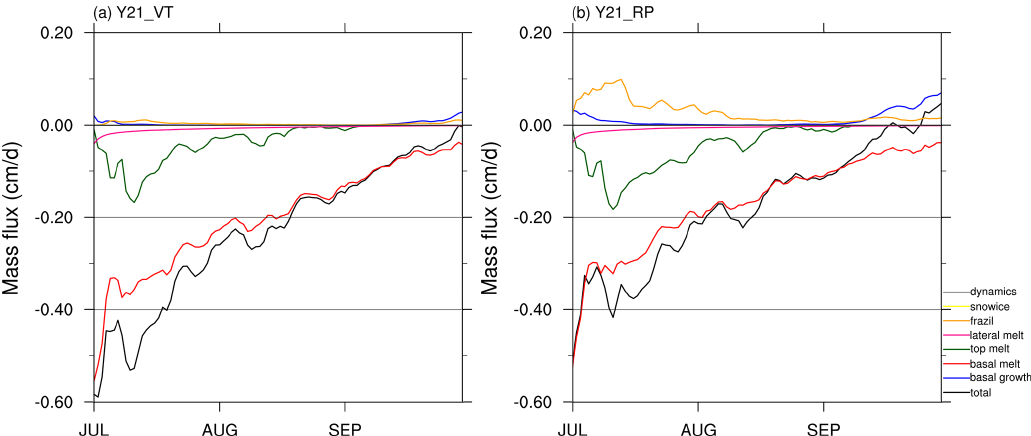
Figure 9. Same as Fig. 6 but for (a) Y21_VT (changes in the ocean vertical coordinate) and (b) Y21_RP (changes in the oceanic advection).